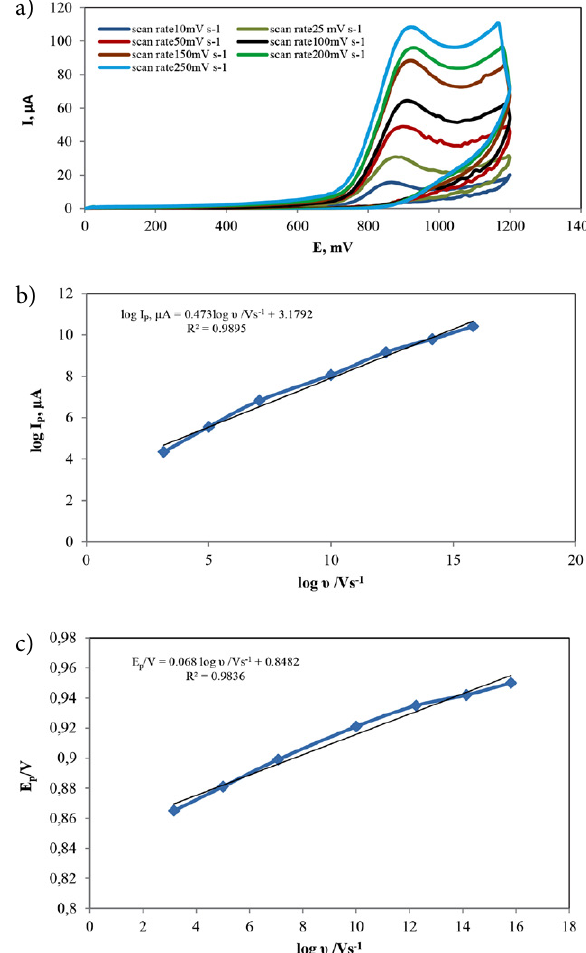
Figure 7. (a) The CV of 1.0 mM SLC containing 0.03 mM SDS in BR buffer of pH 7.0 at 40% SMCPE at different scan rates, (b) Depend- ence of the logarithm of peak current Ip/µA on logarithm of scan rate (υ /Vs −1 ). (c) Relationship between peak potential E p /V and logarithm of scan rate log (υ/Vs −1